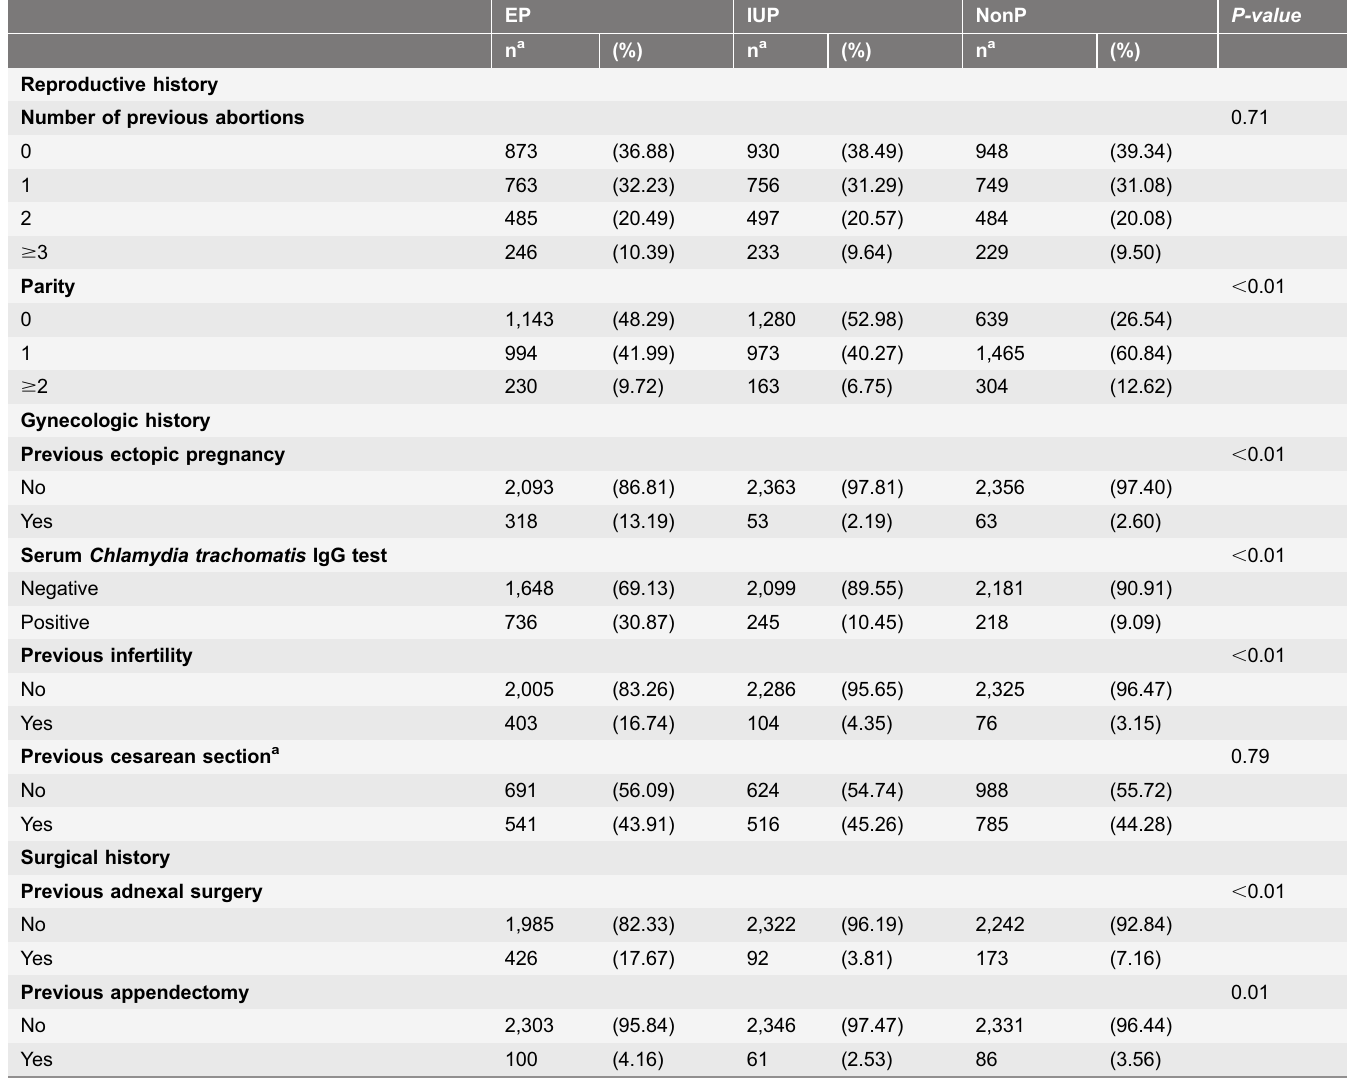
Table 2. Baseline characteristics (history of reproduction, gynecology, and